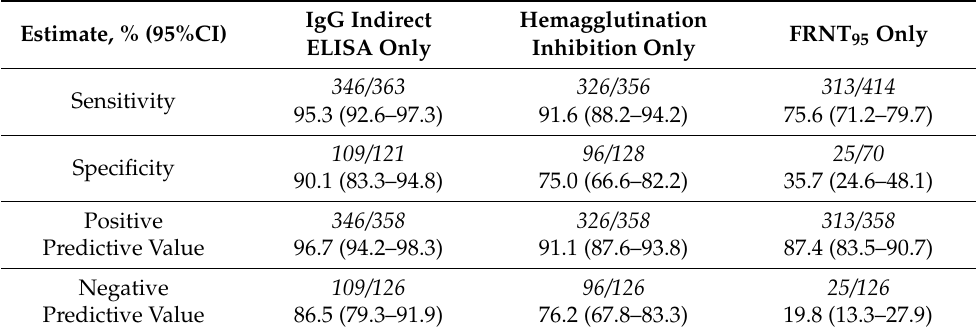
Table 3. Accuracy of ViroTrack Dengue Serostate as compared to individual reference tests used in the reference standard of previous dengue diagnosis.